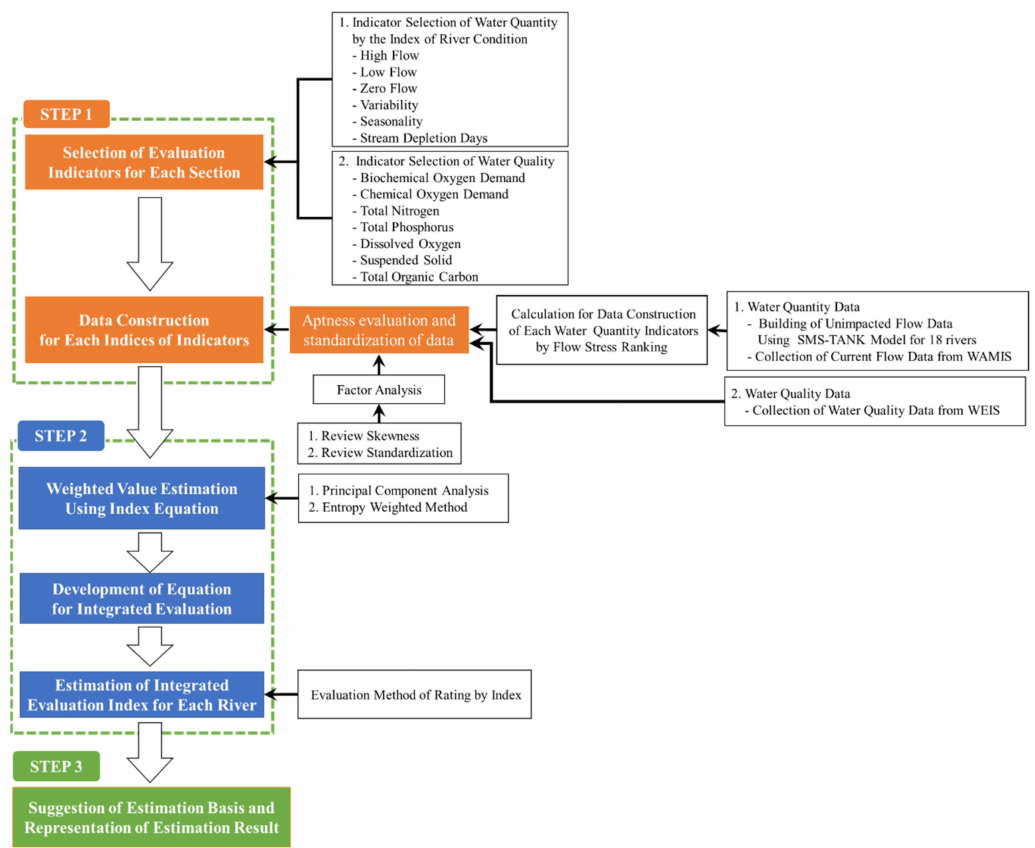
Figure 2. The process of deriving an integrated evaluation of water quantity and water